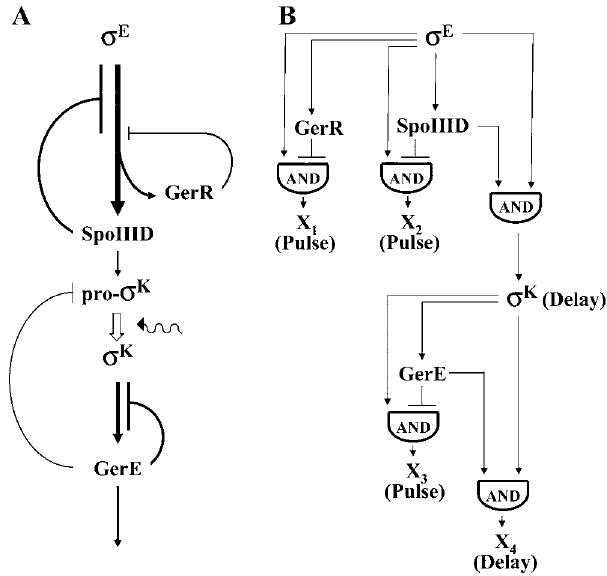
Figure 1. The Mother-Cell Line of Gene